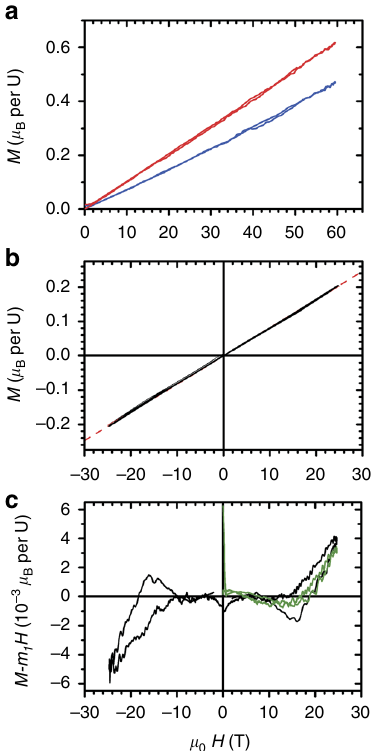
Fig. 3 Magnetization versus magnetic fi eld in UO 2 . a Magnetization M vs. magnetic fi eld μ 0 H measured in a pulsed magnet to 60 T, with H parallel to [111], in the AFM ( blue curve , T = 4 K) and paramagnetic ( red curve , T = 35 K) states. Besides a reduction in the slope at low temperatures, very little structure is observed. The maximum induced moment is 0.5 – 0.6 μ B per U. b Magnetization vs. fi eld measured to 20 T ( T = 4 K) for both positive and negative magnetic fi elds. No structure or irreversibility is evident to the naked eye. The red dashed line is a linear fi t to the data, with slope m 1 = 7.12 × 10 − 3 μ B T − 1 per U. c When a linear contribution is subtracted, some structure becomes apparent. Black lines depict the resultant magnetization on the fi rst fi eld pulse after cooling the sample in zero fi eld in each direction. Green lines depict the data obtained on a second pulse applied in the same becomes apparent. Black lines in Fig. 3c depict the magnetization after subtraction of a linear term on the fi rst fi eld pulse in each direction, right after ZFC-ing the sample. Green lines illustrate the data obtained on a second pulse in the same direction. are clearly seen, which coincides with H coer seen in the MS.